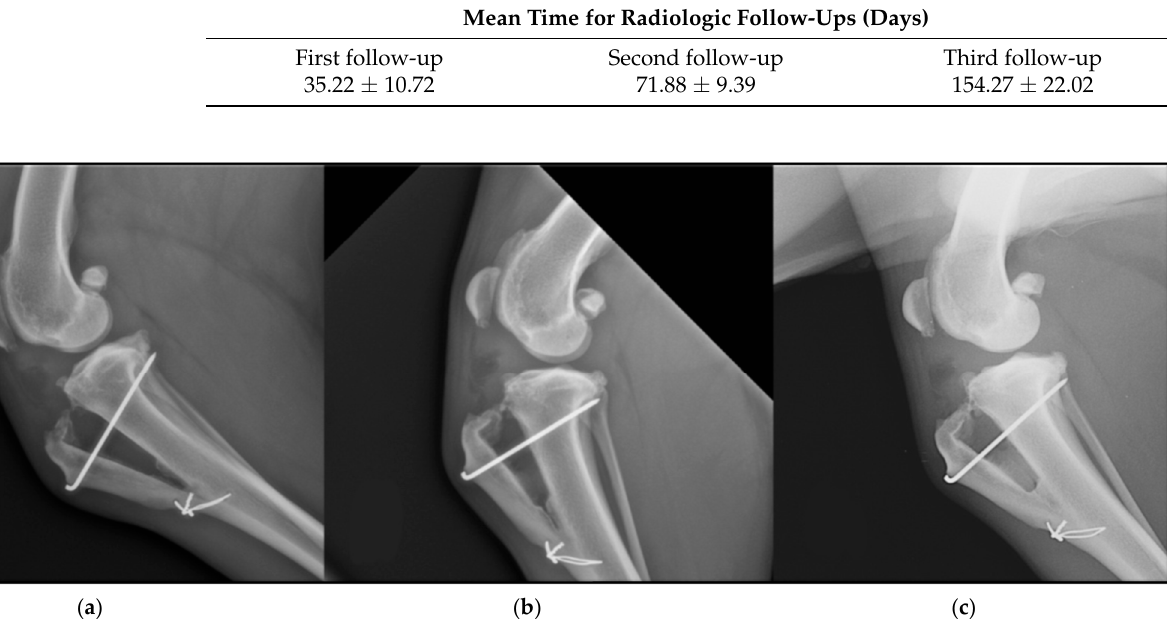
Table 2. Number of patient per follow ‐ up for ossification degree assessment.